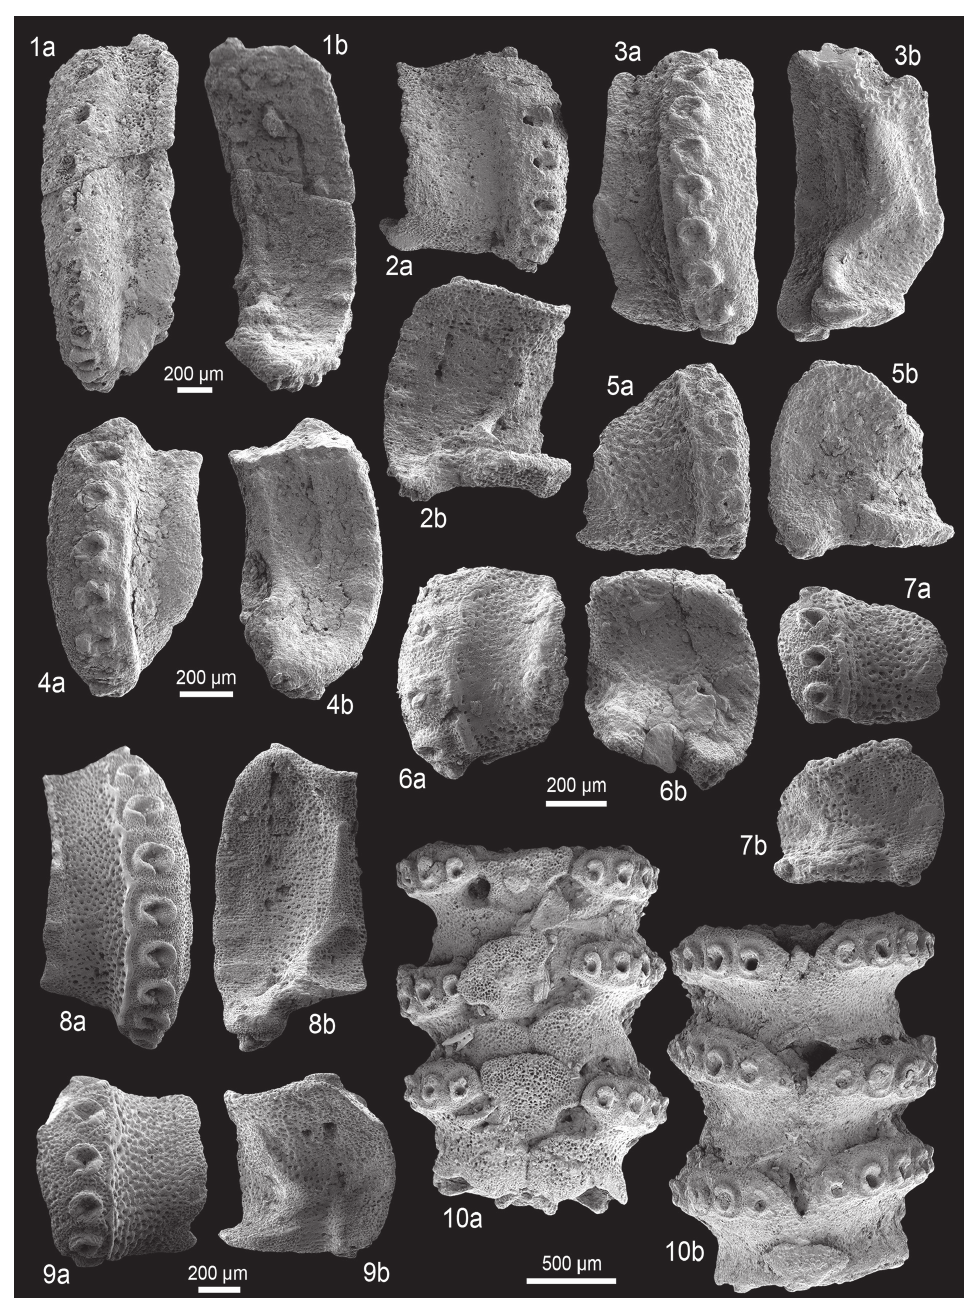
Fig. 20. Fossil lateral arm plates (LAPs) of ophiacanthid brittle stars in external (a) and internal (b) views and articulated arm fragment. 1-2. Ophiogaleus dorecki (Hess, 1962) comb. nov. from the late Pliensbachian (Early Jurassic) of Seewen, Switzerland. 1. NHMB M11214, proximal LAP. 2. NHMB M11215, distal LAP. 3-5. Ophiogaleus stans sp. nov. from the early Bathonian (Middle Jurassic) of La Pouza, France. 3. GZG.INV.78615 (holotype), proximal LAP. 4. GZG.INV.78616 (paratype), median LAP. 5. GZG.INV.78617 (paratype), distal LAP. 6-7. Ophiogaleus sp. nov. innom 2 from the Callovian (Middle Jurassic) of Jumara, India. 6. GZG.INV.78619, proximal LAP. 7. GZG.INV.78620, distal LAP. 8-10. Ophiogaleus constrictus (Hess, 1966) comb. nov. from the late Oxfordian (Late Jurassic) of Savigna, France. 8. GZG.INV.78624, proximal LAP. 9. GZG.INV.78625, distal LAP. 10. GZG.INV.78626, proximal arm fragment in ventral (a) and dorsal (b) views. One common scale bar per species except for